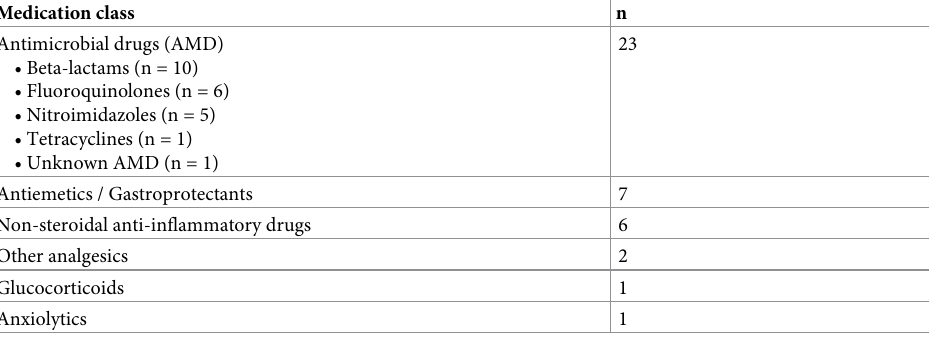
Table 2. Medications prescribed to dogs with sepsis prior to study